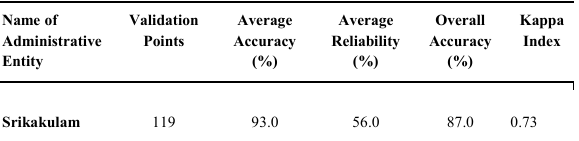
Table 2. Summary of accuracy assessment of satellite-based rice area with e-panta data.